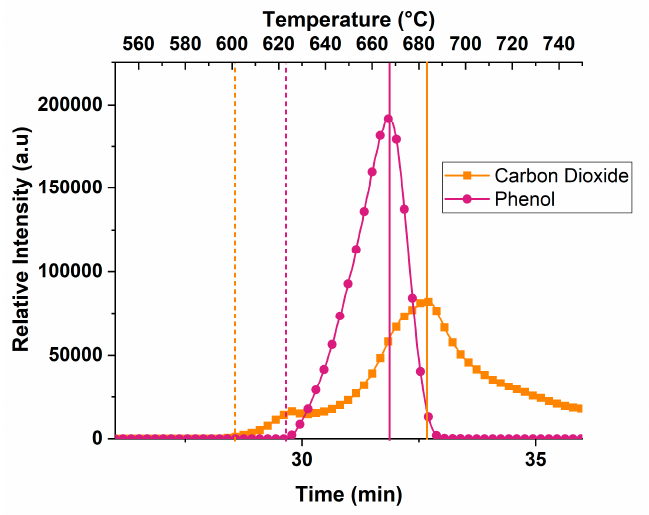
Figure 5. Intensity profiles of carbon dioxide (gold, m/z = 44) and phenol (violet, m/z = 94) using EGA–MS at a heating rate of 20 °C/min under helium. The dashed lines indicate the moment where the corresponding product is detected. The filled lines correspond to the temperature (or time) whereby the maximum intensity of a product is analyzed.